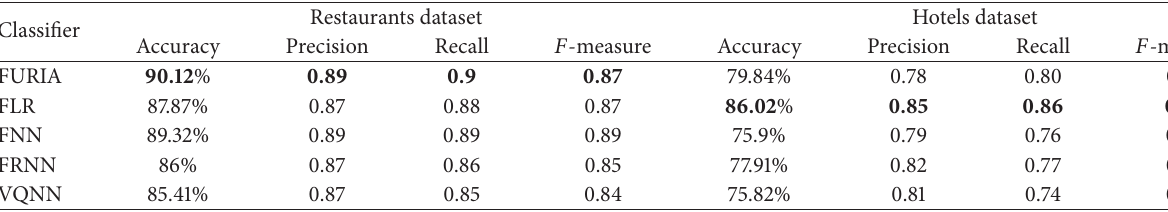
Table 3: Classifiers performance on restaurants and hotels dataset.